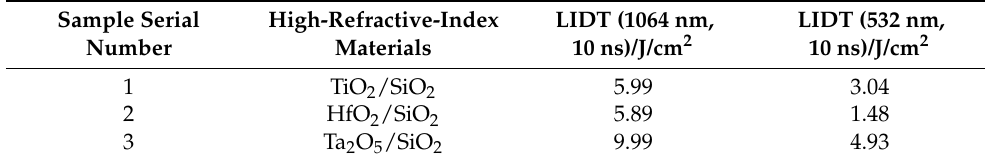
Figure 4. Transmission spectra of the non-regularized highly reflective Ta 2 O 5 /SiO 2 film before and after testing at ( a ) 1064 nm and ( b ) 532 nm. Table 2. Damage resistance of highly reflective laser protection